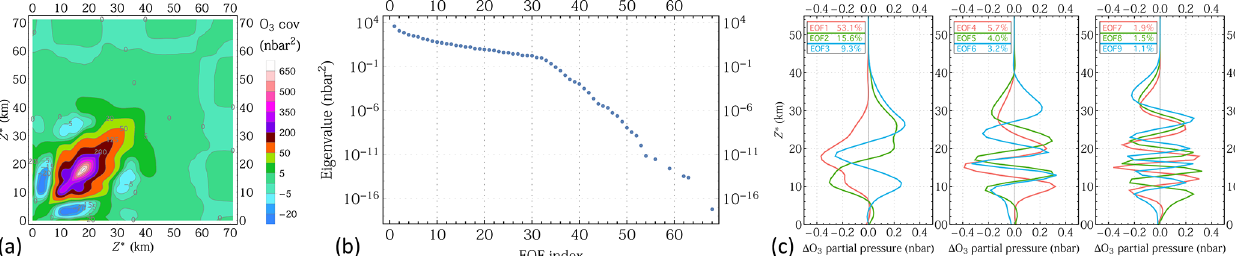
Figure B1. (a) The covariance matrix for October and the midlatitude (50–40 ◦ S) zone, (b) eigenvalues of the covariance matrix in (a) , and (c) the first nine leading EOFs of the matrix in (a)